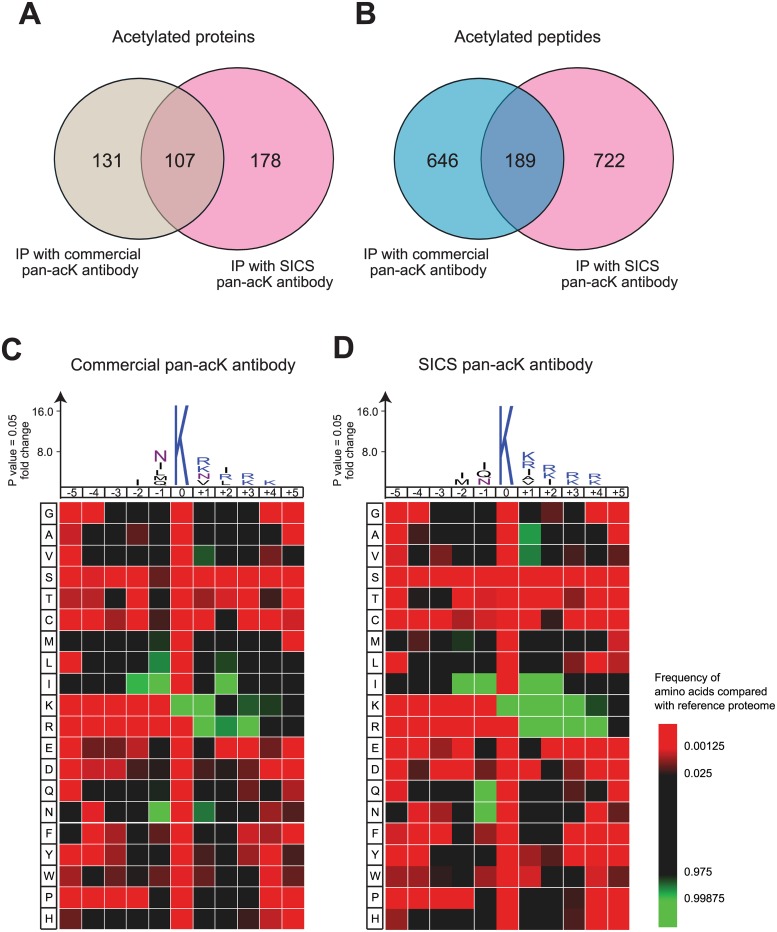
Identification of acetylated peptides by LC-MS/MS and their consensus sequence motif.Overlap of identified acetylated proteins (A) and peptides (B) from HEK293 cells using commercial pan-acK antibody or SICS pan-acK antibodies. (C and D) Peptide sequence motif and heat map of amino acids flanking the acetyl-lysine (P < 0.05). The height of amino acids on the peptide motif represents fold change above background. Significance was set at p-value < 0.05. The color intensity of an amino acid in the heatmap reflects the difference in the frequency of an amino acid in the experimental data set and its reference data set.